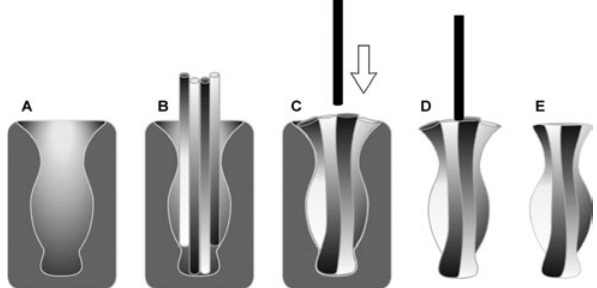
Figure 5. Fuse-casting of glass objects: (A) production of black mold; (B) glass pieces added, heated to fuse and fill mold; (C) metal rod inserted; (D) mold removed; (E) piece ground and polished to finish [adapted from reference 42 with permission from Springer